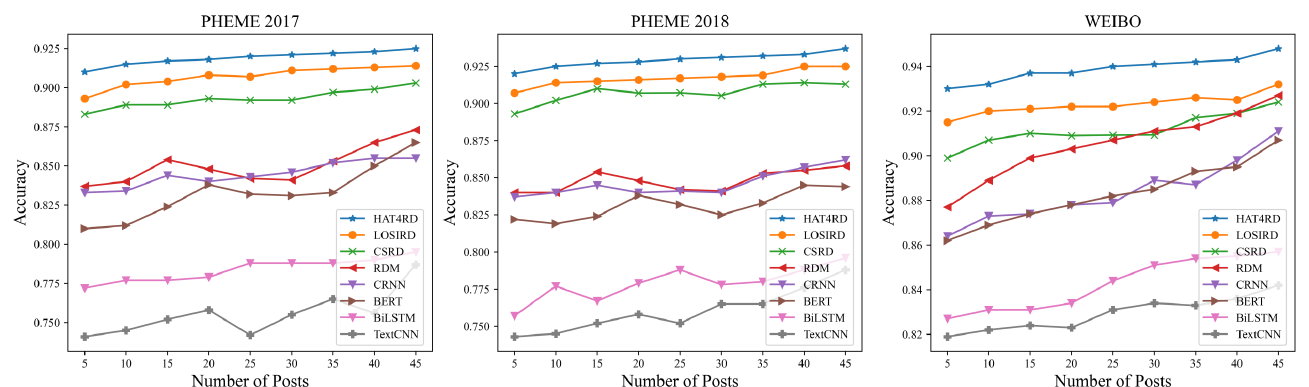
Figure 5. Early rumor detection accuracy.